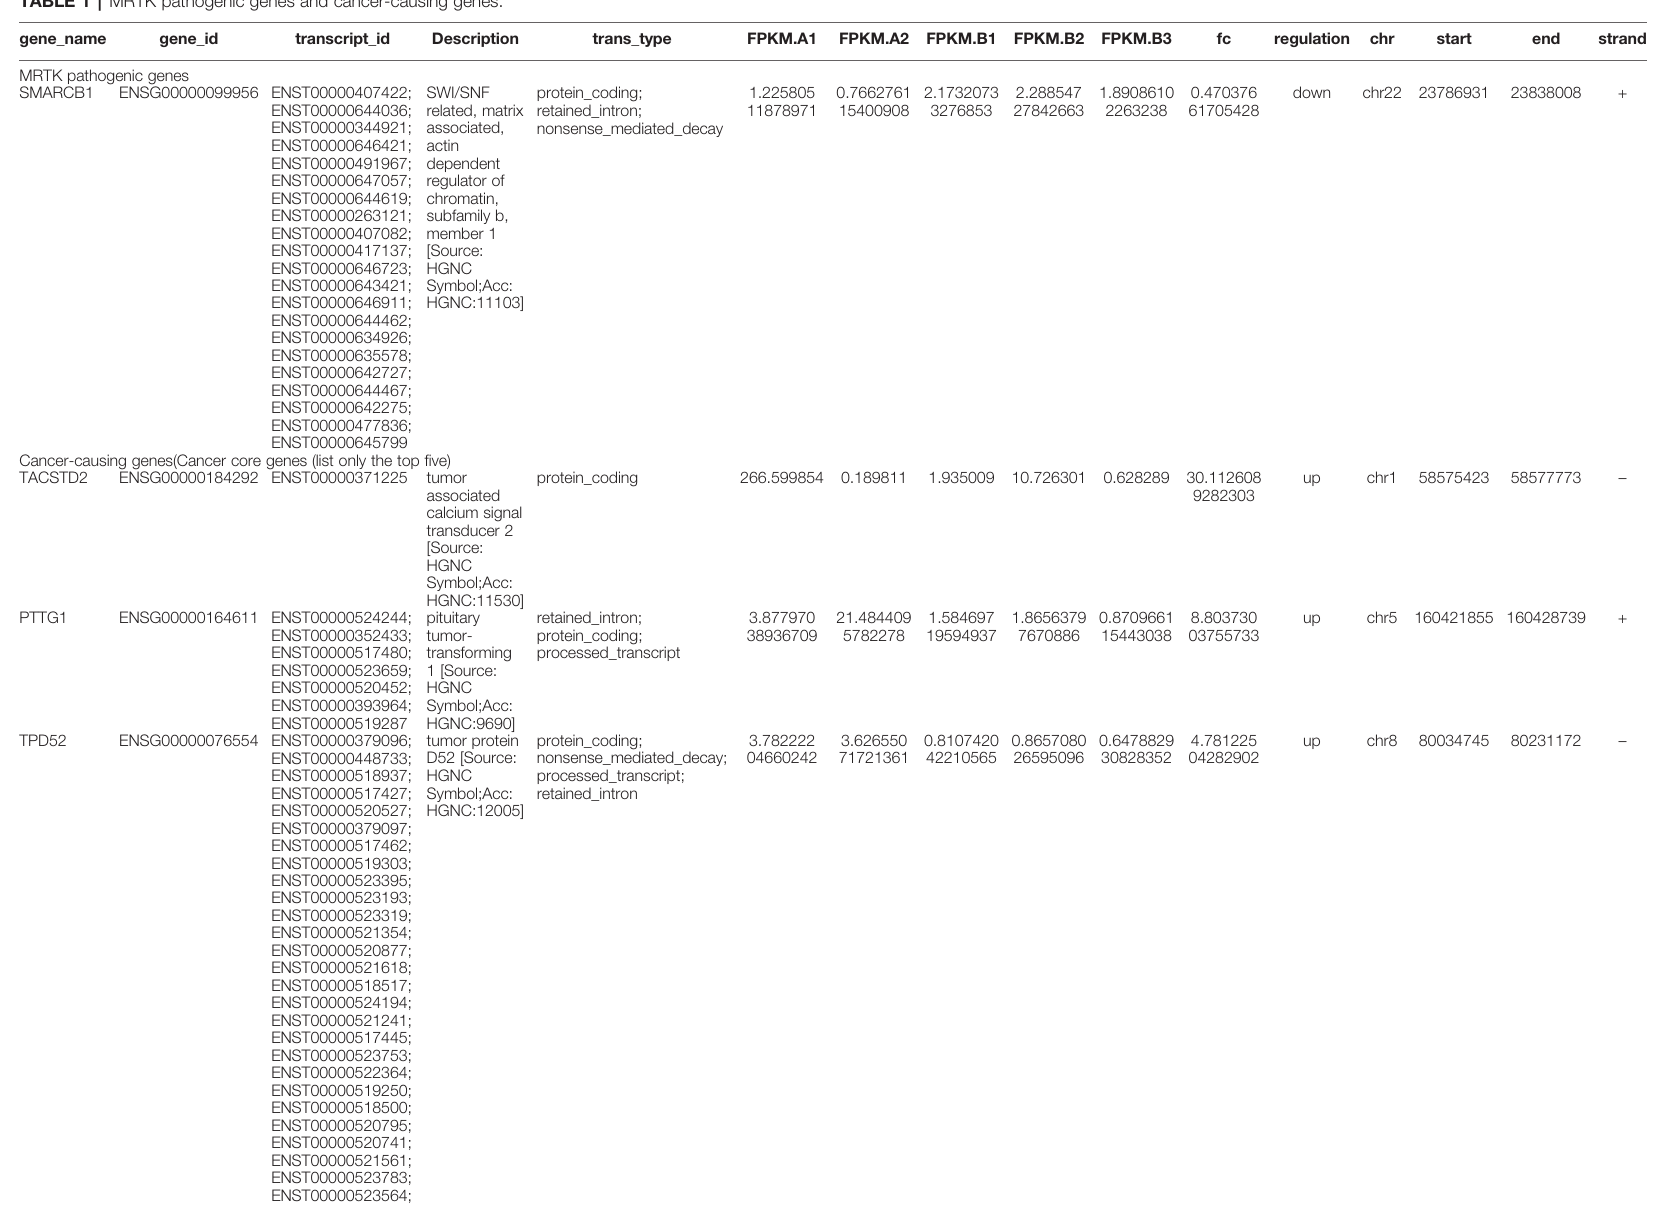
TABLE 1 | MRTK pathogenic genes and cancer-causing